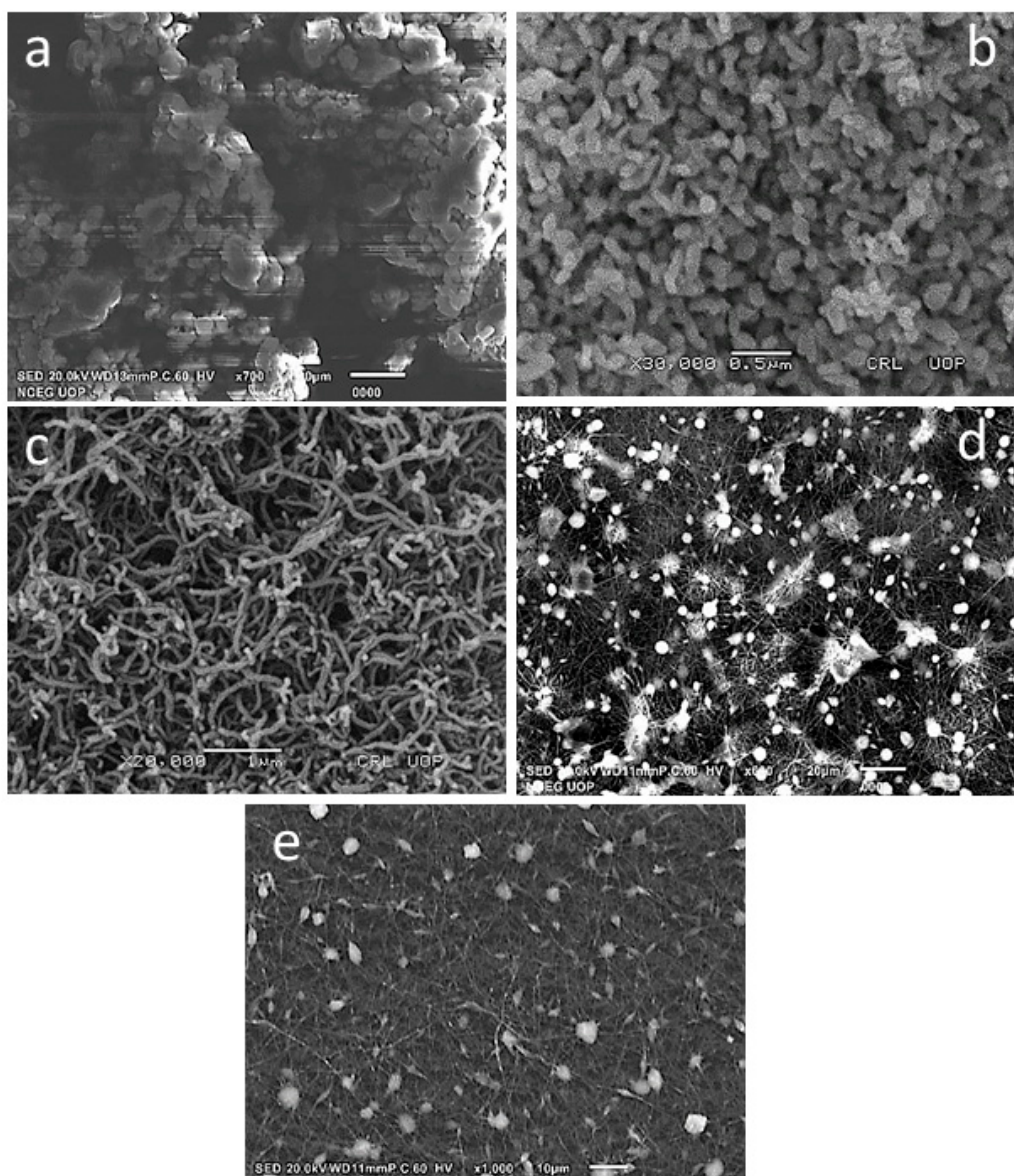
Figure 1. SEM micrographs of ( a ) pure PEO ( b ) CuO nanoparticles ( c ) multi-walled carbon nanotubes (MWCNT) ( d ) PEO: CuO: MWCNT: 1% nanofibers ( e ) PEO: CuO: MWCNT: 3% nanofibers.